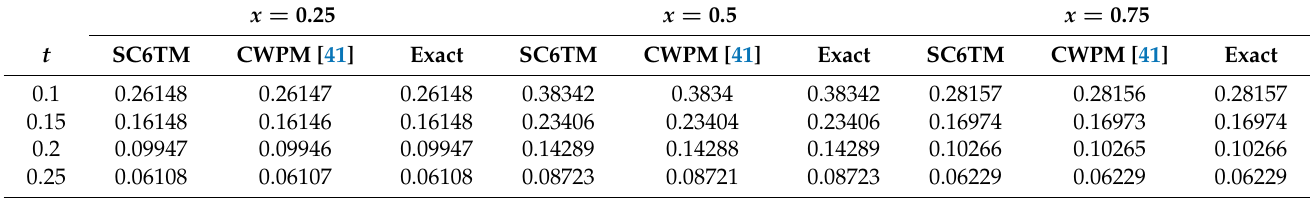
Table 1. Comparison between the exact solution, CWPM solution and SC6TM solution of Example 1. x = 0.25